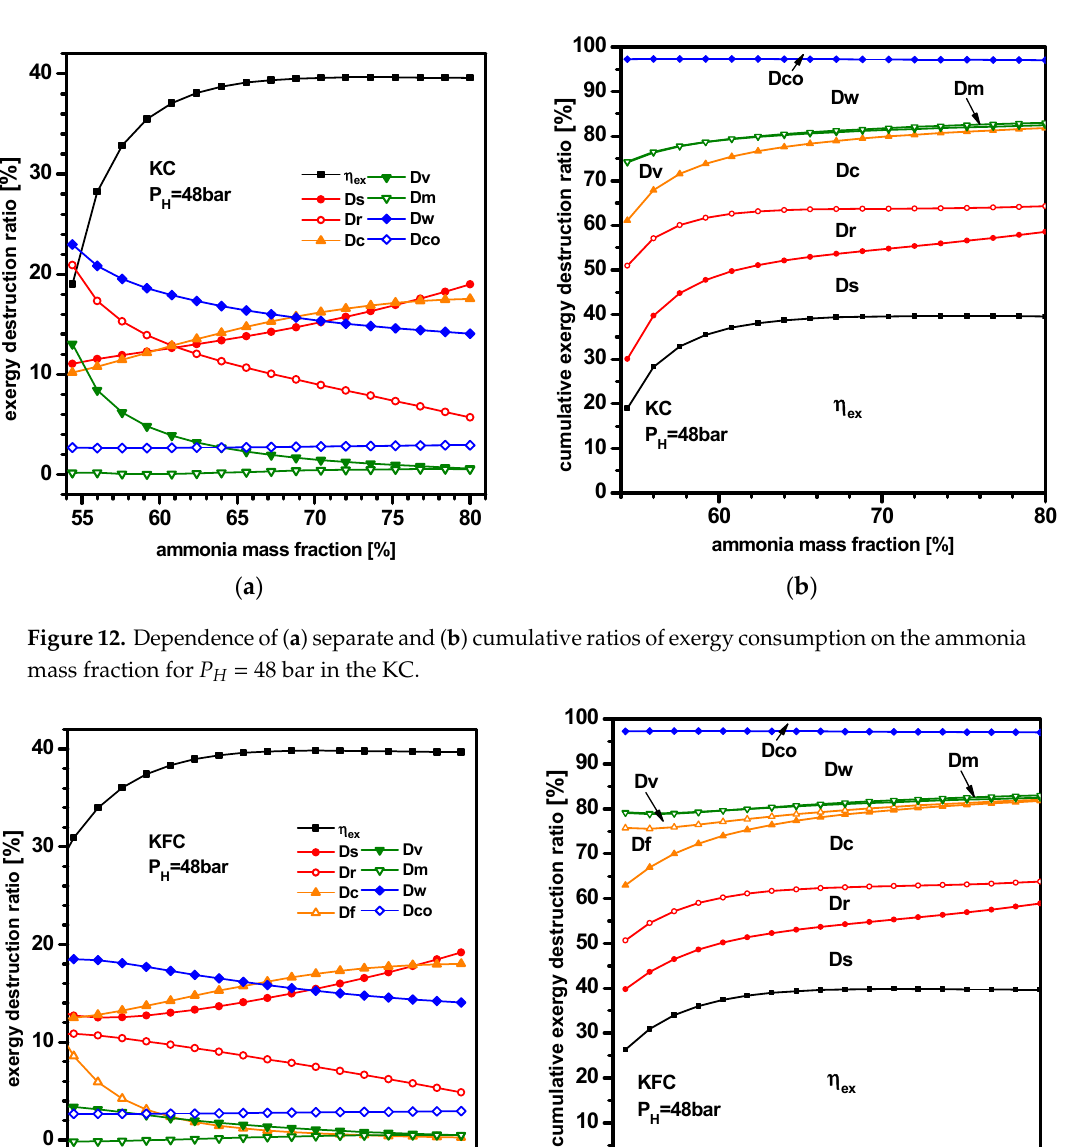
( b ) Figure 11. Dependence of ( a ) separate and ( b ) cumulative ratios of exergy consumption on the ammonia mass fraction for P H = 16 bar in the KFC. Figures 12 and 13 show the dependence of (a) separate and (b) cumulative ratios of exergy consumption on the basic ammonia mass fraction ( x b ) for separator pressure of 48 bar in the KC and KFC, respectively. As the ammonia fraction increases, the fractions of exergy consumed to generate power ( η ex ), and destroyed in the HRVG ( Ds ) and condenser ( Dc ) increase; by contrast, those destroyed in power components ( Dw ), regenerator ( Dr ), and throttle valve ( Dv ) decrease. The exergy